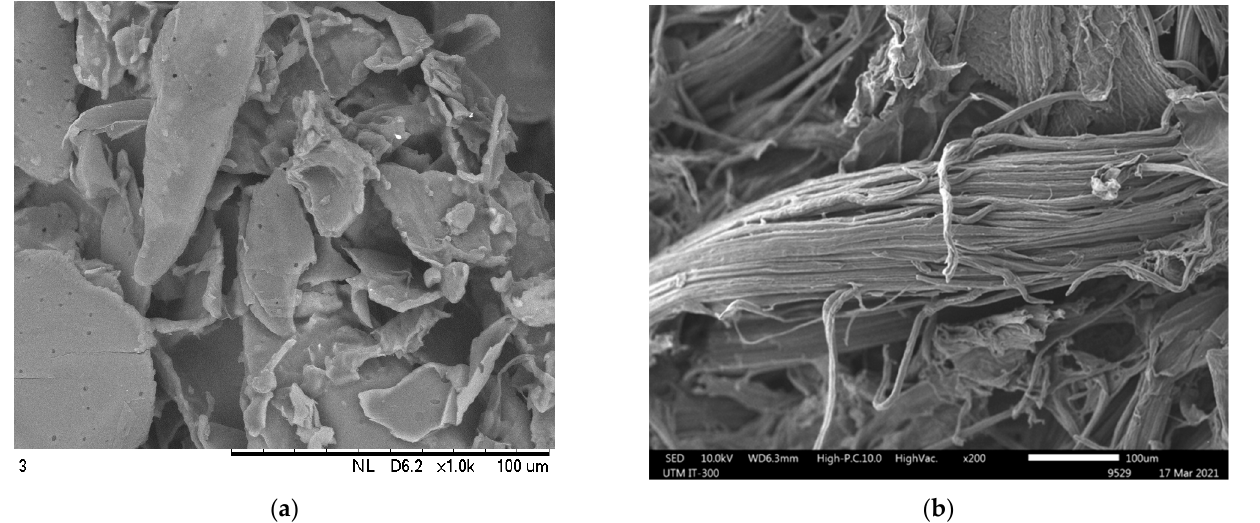
Figure 5. SEM images of ( a ) raw bagasse; ( b ) extracted bagasse at 100 µm